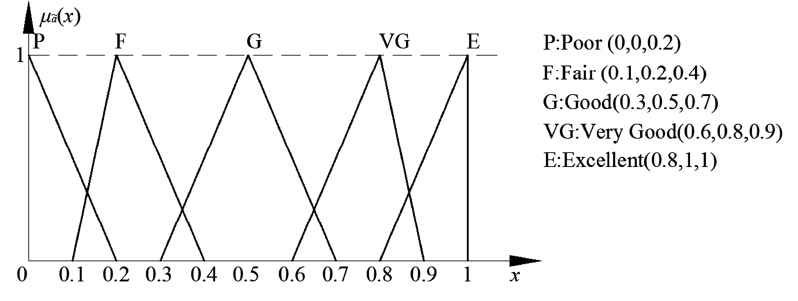
Figure 2. TFNs of fuzzy linguistic terms.